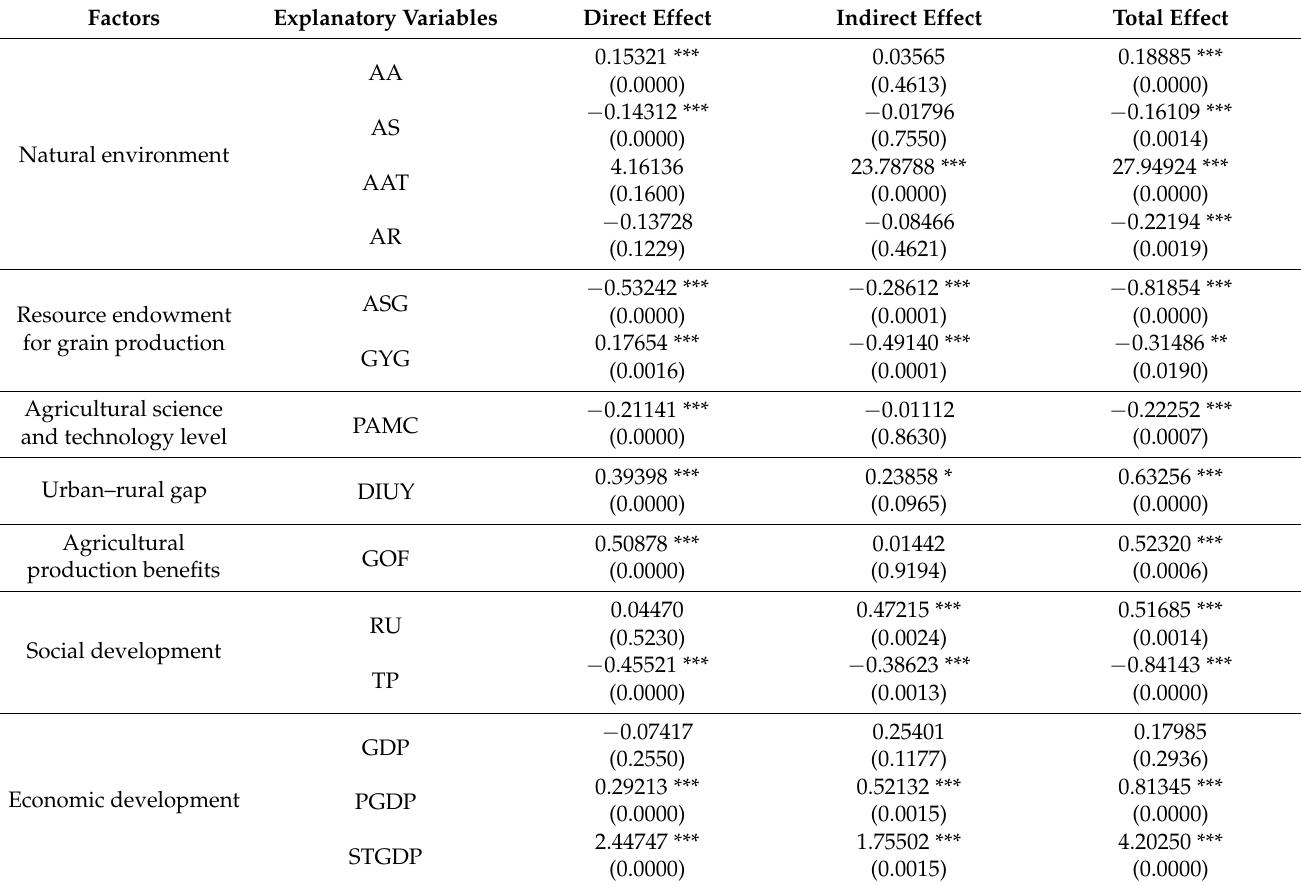
Table 6. Spatial spillover effects of